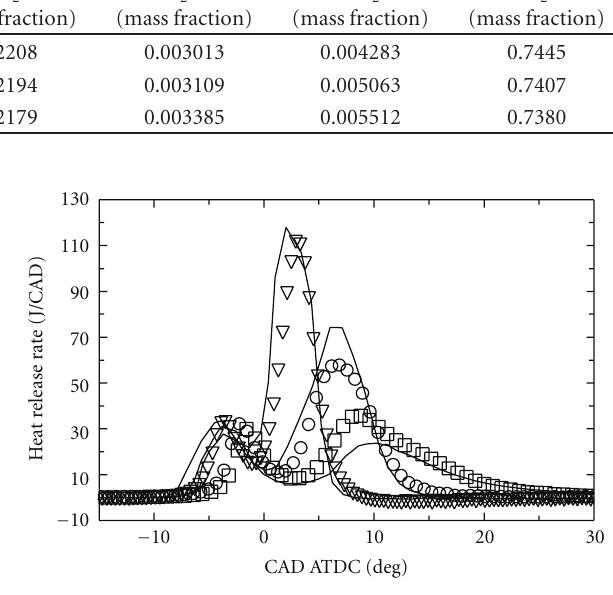
Figure 6: Comparisonof cylinder pressure traces versus crank angle Figure 7: Comparison of heat release rates versus crank angle degree after top dead center (CAD ATDC). Symbols: experimental degree after top dead center (CAD ATDC). Symbols: experimental data from a CFR engine with di ff erent equivalence ratios ( φ ): data from a CFR engine with di ff erent equivalence ratios ( φ ): (cid:2) ( φ = 0 . 358); (cid:2) ( φ = 0 . 317); (cid:2) ( φ = 0 . 358); (cid:2) ( φ = 0 . 317); ( φ = 0 . 277); Solid lines: detailed ( φ = 0 . 277); Lines: detailed DME (cid:3) (cid:3) DME chemistry [10]; Dashed lines: 28-species reduced chemistry chemistry (this work).